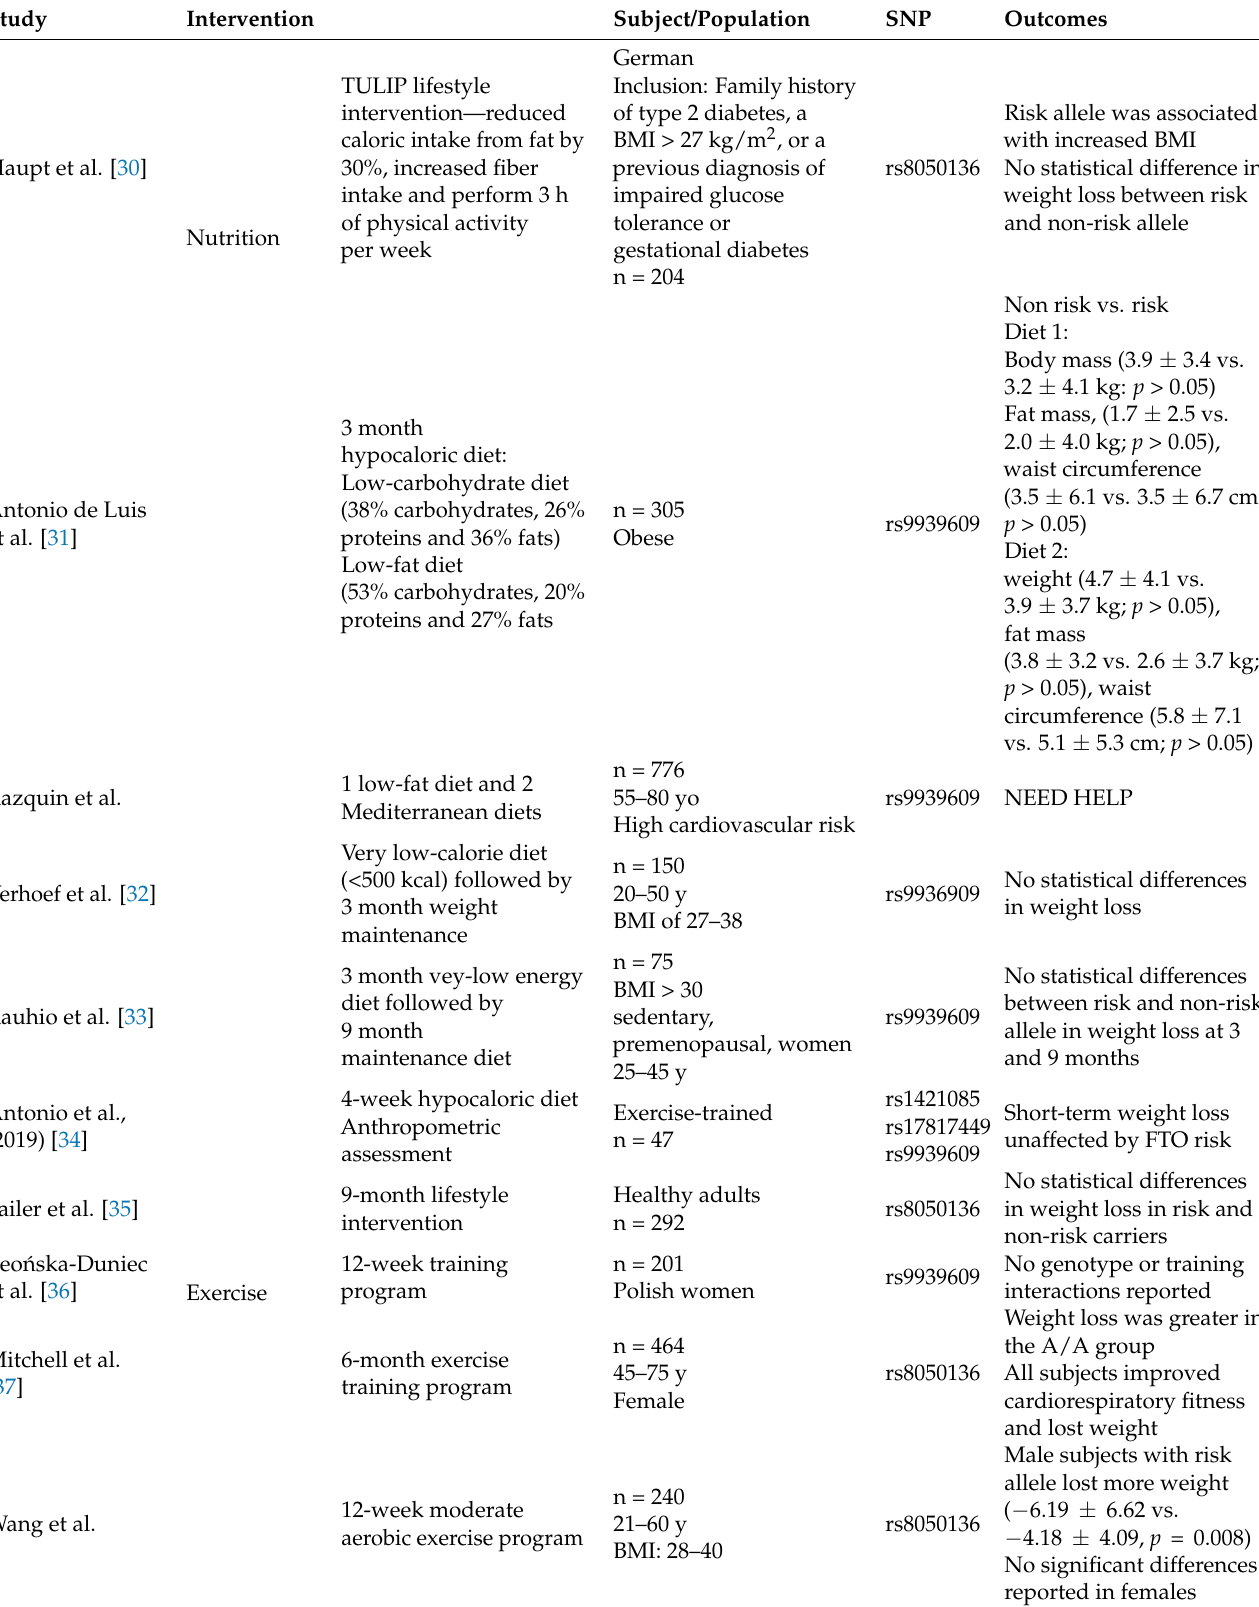
Table 3. Summary of intervention